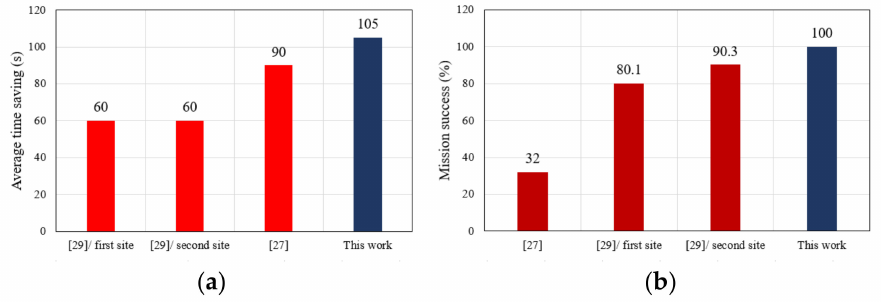
Figure 19. Comparison between the UAV-based system proposed here and other works for ( a ) Time savings and ( b ) Mission